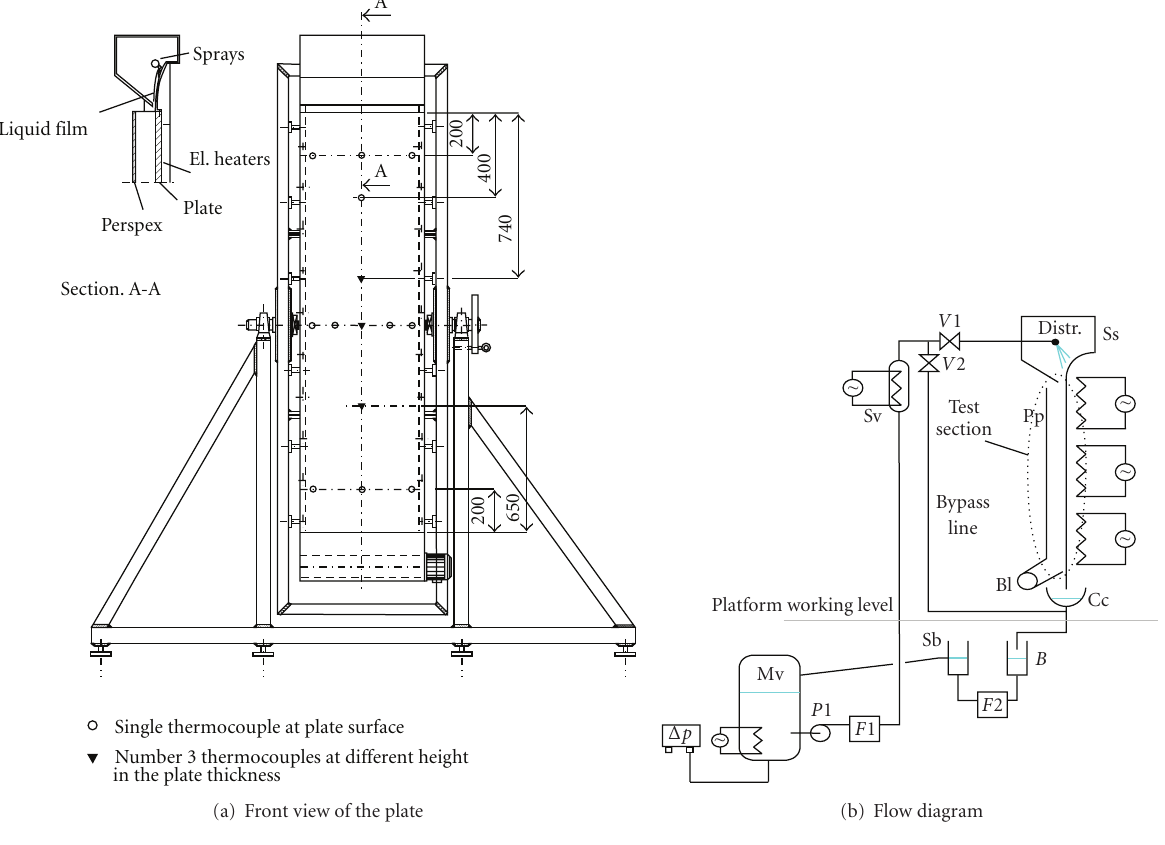
Figure 4: EFFE Experimental